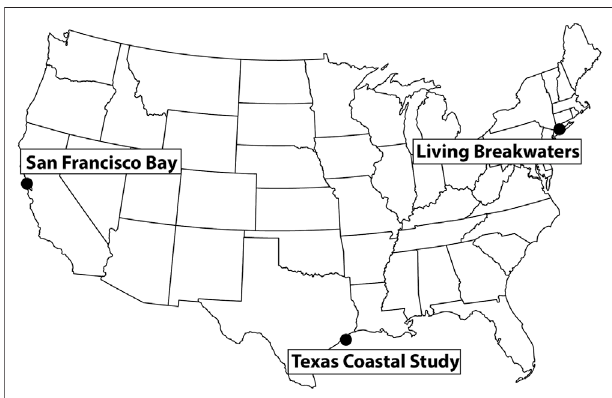
FIGURE 1 | Overview map of project